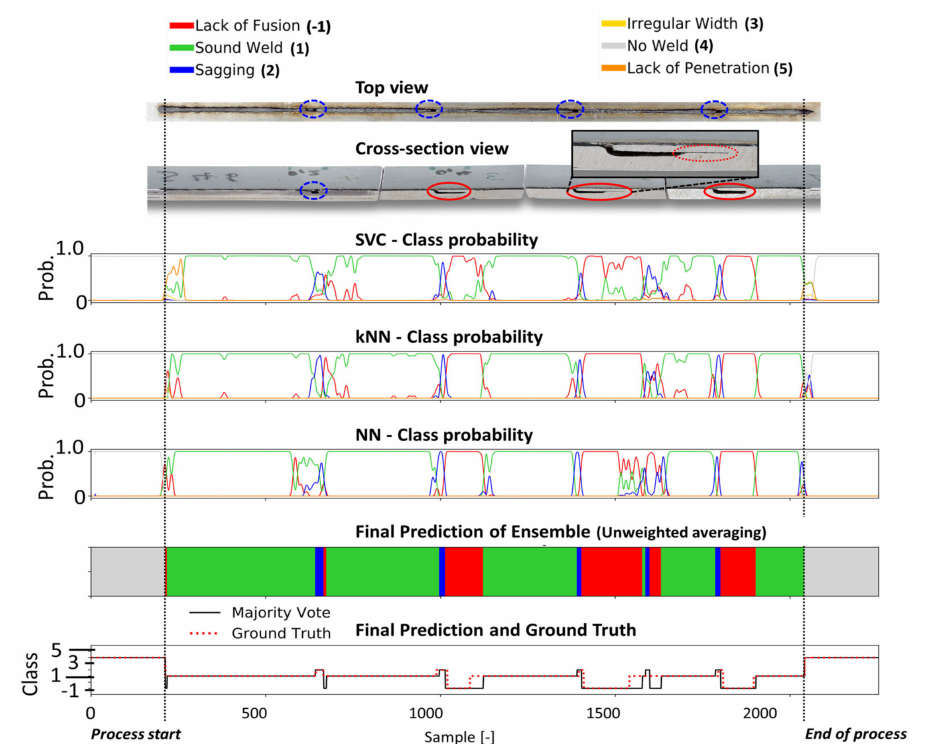
Figure 11. The metallographic characterization, the resulting ground truth data and the classification results for weld 46 based on the proposed ensemble CNN-GRU architecture.